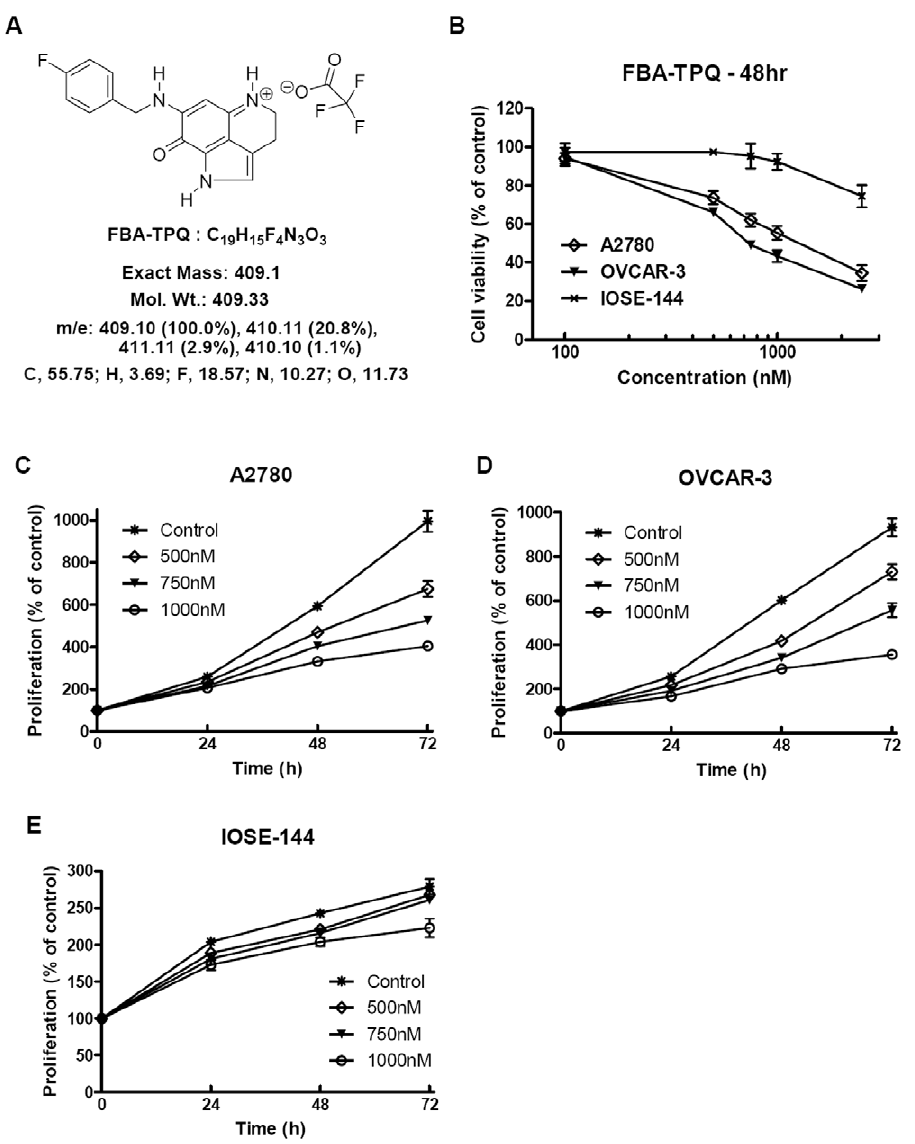
Figure 1. FBA-TPQ preferentially decreases cell viability and growth of A2780 and OVCAR-3 cells but not normal IOSE-144 cells. A, Chemical structure and molecular formula of FBA-TPQ; B, Cell viability (MTS) assay of human ovarian carcinoma cells (A2780 and OVCAR-3) and nontumorigenic OSE cells (IOSE144) after a 48 h incubation with FBA-TPQ; C&D&E, Cell growth inhibition after 0, 24, 48 or 72 h exposure of A2780 (C), OVCAR-3 (D) and IOSE-144 (E) cells to FBA-TPQ(at concentrations of 0, 0.5, 0.75 and 1.0 m M). All values are representative of at least three independent experiments with similar results, and are presented as the percentage of cell growth inhibition, where vehicle-treated cells were regarded as 100% viable (0% growth